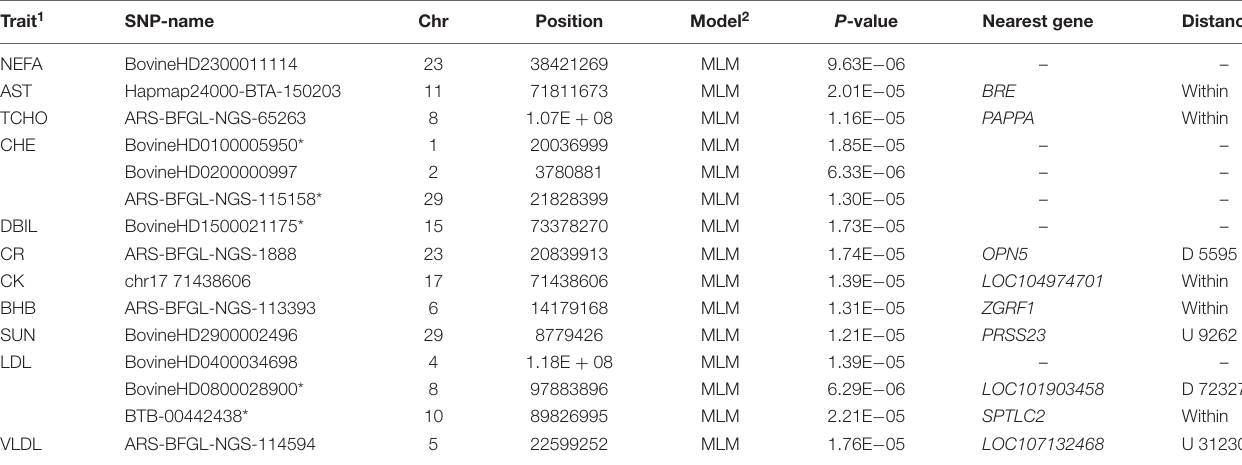
TABLE 2 | SNPs identified to have genome-wide suggestive effects on serum biochemical traits in Holstein cattle using a mixed-effect linear model. Trait